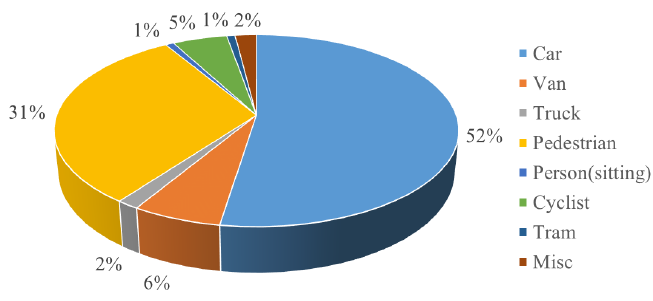
Figure 11. The proportion of various objects in the KITTI dataset.